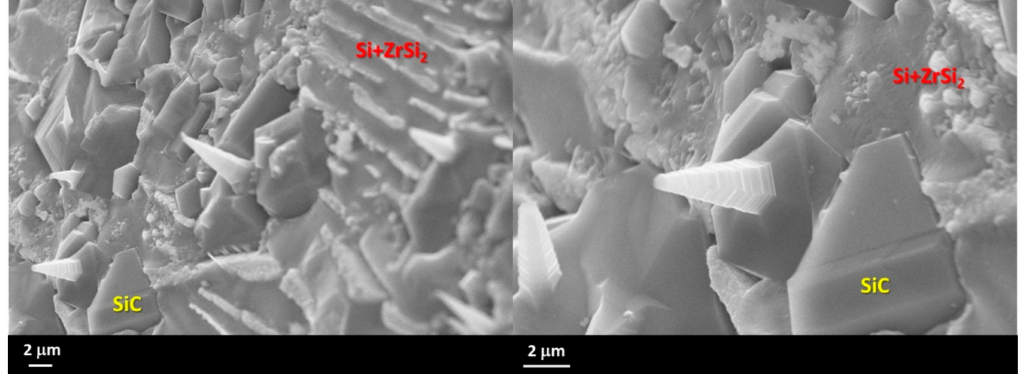
Figure 8. SEM images at two di ff erent magnifications and proposed phase identification by EDS analyses that were performed near the triple line of the Si-27Zr / GC sample after the wetting tests that were performed at T = 1450 ◦ C for 45 minutes. ( a ) left; ( b )